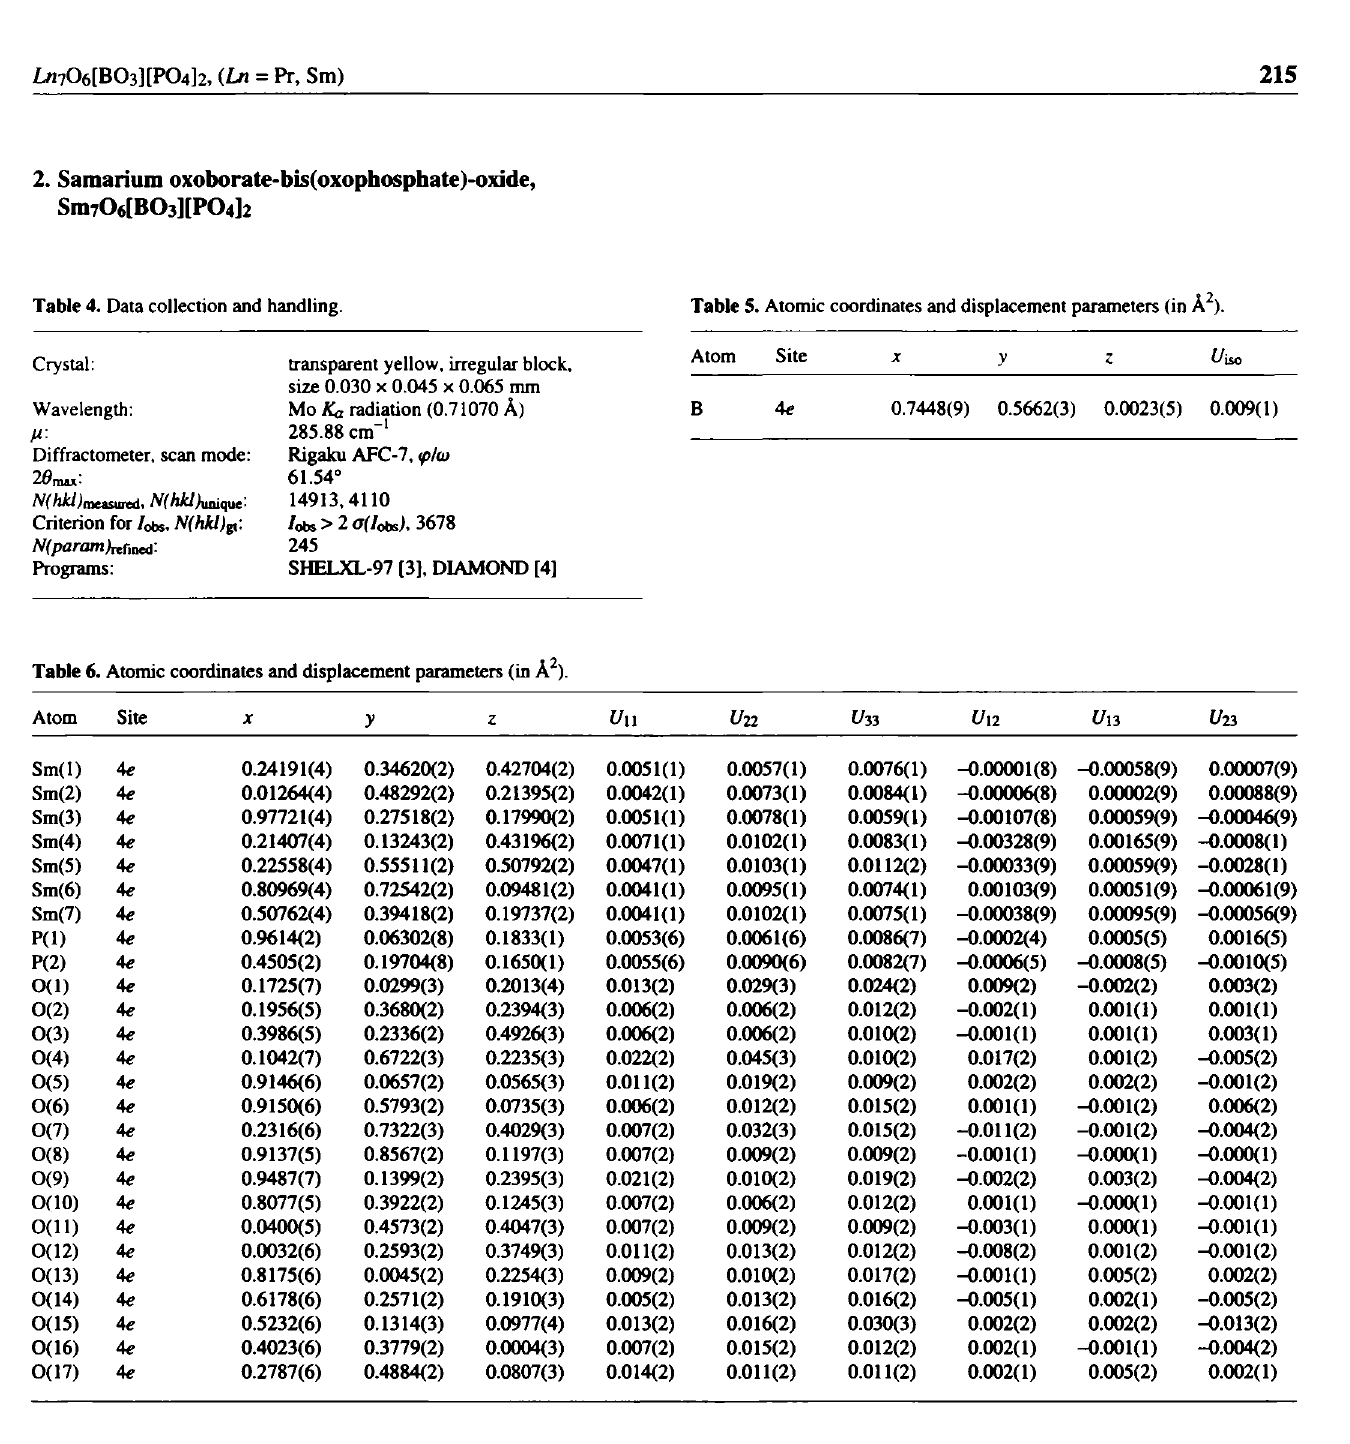
Table 4. Data collection and handling. Table 5. Atomic coordinates and displacement parameters (in Â 2 ).